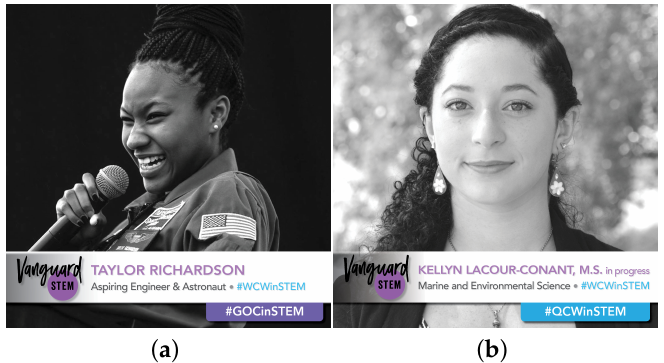
Figure 6. We continue to evolve and expand our programming to meet the needs and interests of our community. Using the framework we built for #WCWinSTEM, we developed and deployed a feature series for girls of color in STEM (GoCinSTEM; ( a )) like Taylor Richardson, and queer and non-binary people of color in STEM ( b ) like, Kellyn Lacour Conant. These features allow us to continuously write our stories into existence without having to sacrifice who we are in the